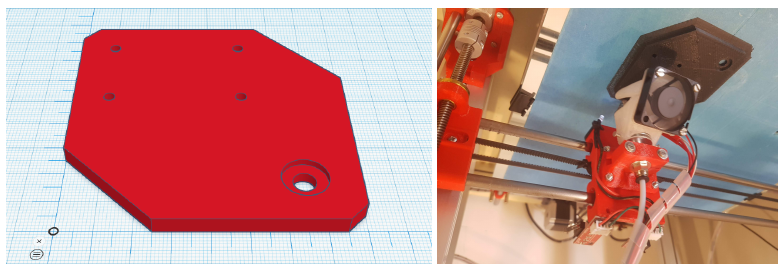
Figure 3. Design of the camera base ( left ) and photograph from its printing on the C3Dp ( right ).